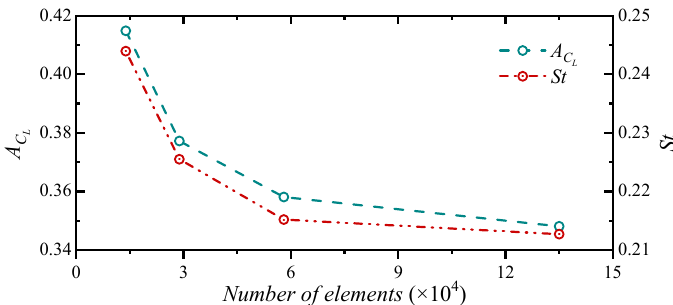
A Figure 3. A C and St based on different grids. L Figure 3. L C and St based on different grids.